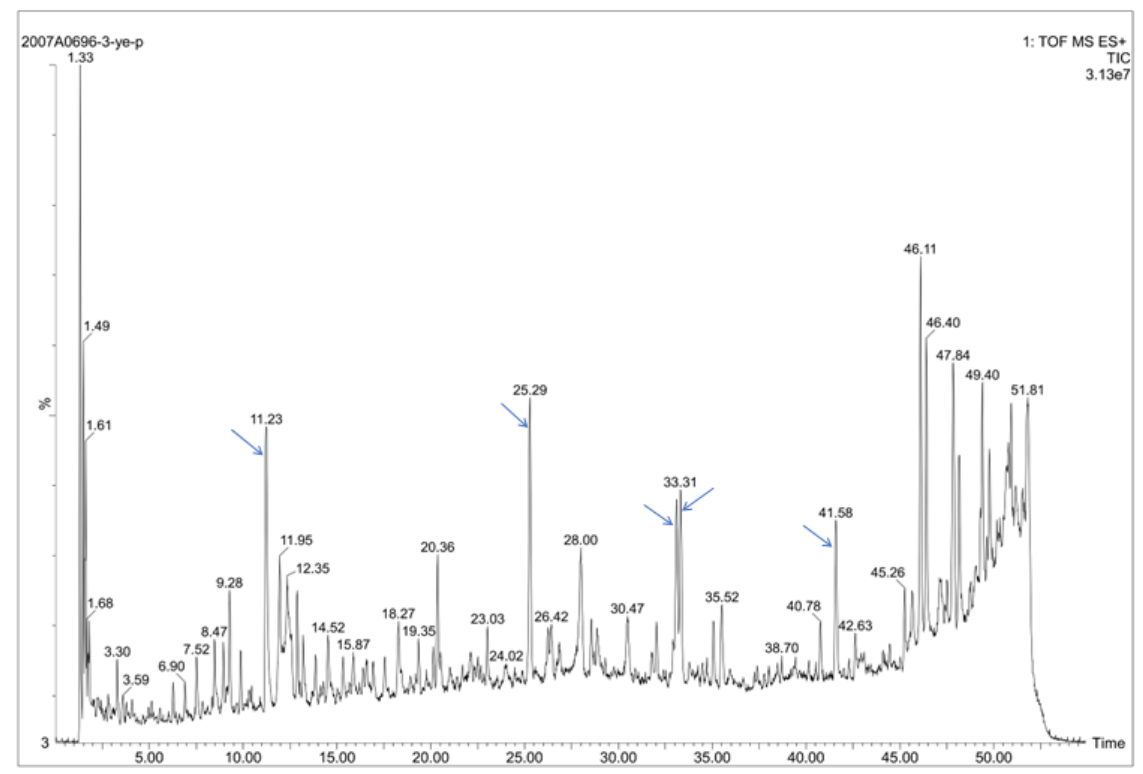
Figure 3. UPLC ‐ UV ‐ ESI ‐ Q ‐ TOF of S. cusia leaves. Blue arrows from left to right point out five main peaks at 11.23 min, 25.29 min, 33.10 min, 33.33 min, and 41.58 min, which represent CQA (includes 3 ‐ CQA, 4 ‐ CQA, 5 ‐ CQA), Hispiduloside, Tryptanthrin, Hispidulin, and Indirubin, respectively. Table 3. Anti ‐ PRSP effect of seven Chemical Reference Substances (CRSs). MICs ( μ g/mL) of Seven CRSs